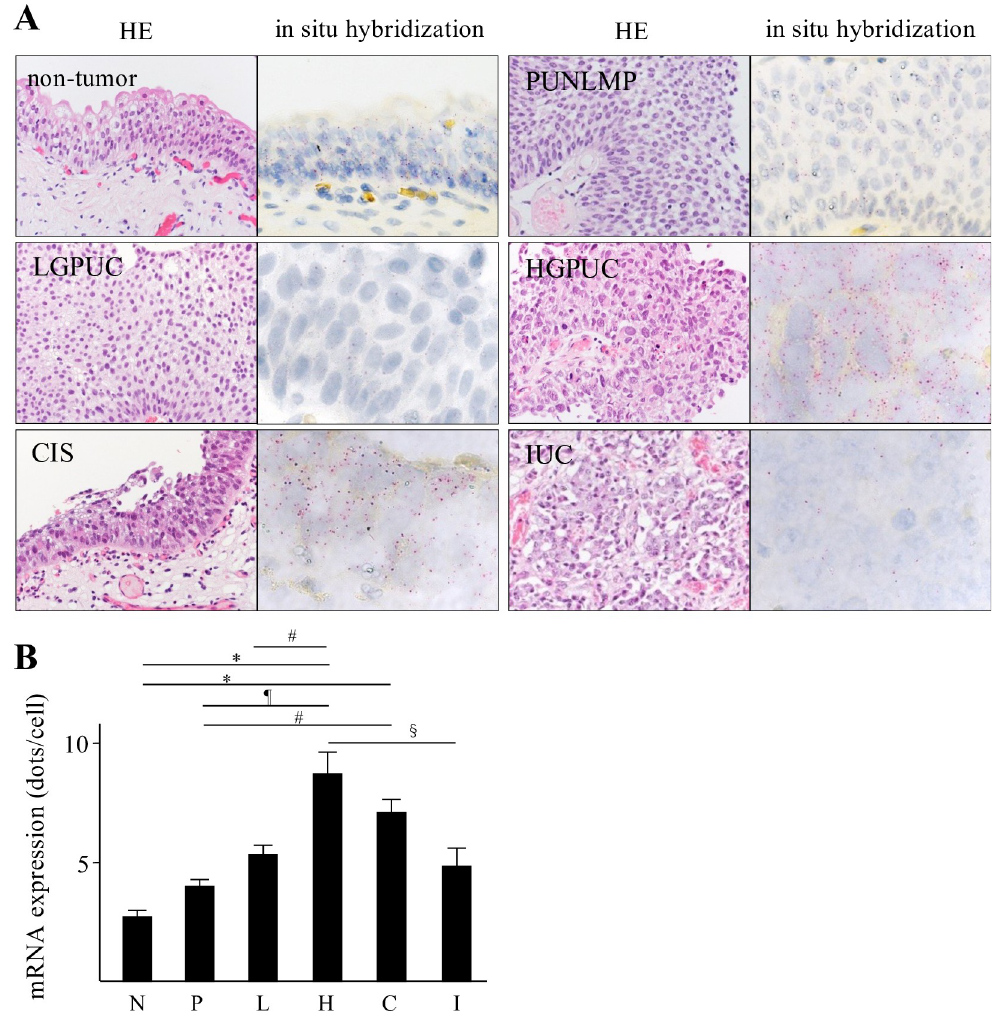
Fig 1. Spred2 mRNA expression in urothelial tumors. (A) Representative photographs of HE- (original magnification 400 × ) and in situ hybridization-sections from each category are shown. Spred2 mRNA expression was presented by red dots. (B) The number of the red-dots per cell was counted under microscope and Spred2 mRNA expression level was shown per one cell from each category (N: non-tumor; n = 10, P: PUNLMP; n = 10, L: LGPUC; n = 15, H: HGPUC; n = 18, C: CIS; n = 18, and I: IUC; n = 14). Data were mean ± SEM. # p < 0.05, § p < 0.01, ¶ p < 0.001, � p < 0.0001 (Dunn’s multiple comparison